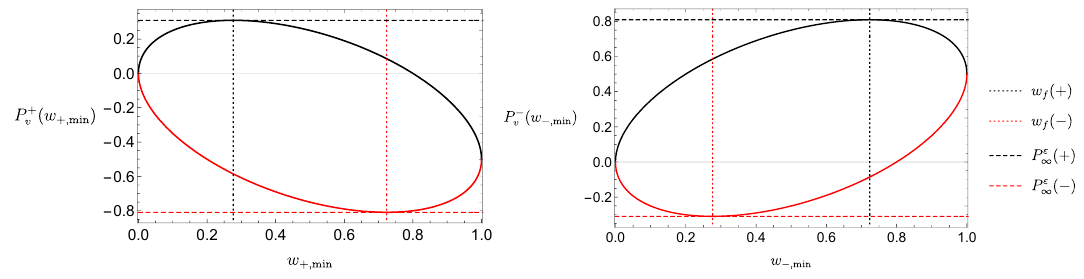
and the minimal Figure 4 . Illustration of the relation between the conserved momentum P ε v radius w in eq. (2.78), for α = 1 = α , x = 1 and d = 2 . The solutions P ε (+) in eq. (2.80) ε, min ± B v correspond to the black arcs, while P ε ( − ) correspond to the red arcs. The critical momenta P ε ( ± ) v ∞ in eq. (2.82) correspond to the maximum and minimum vertical extrema of the ellipses marked by the horizontal dashed lines. The corresponding turning points w ( ± ) given in eq. (2.83) are marked f by the vertical dashed